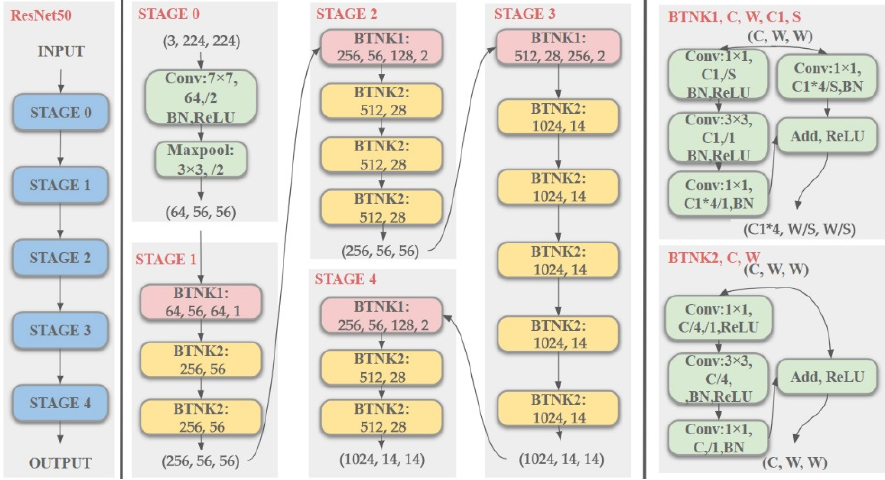
Figure 2. Overall structure of ResNet.